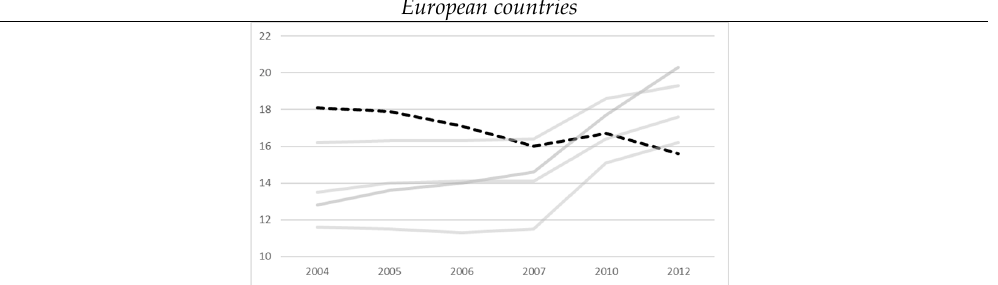
Figure 1. Economic impact of the Great Recession in Germany as compared to the selected Southern European countries (Italy, Spain, Portugal, and Greece).